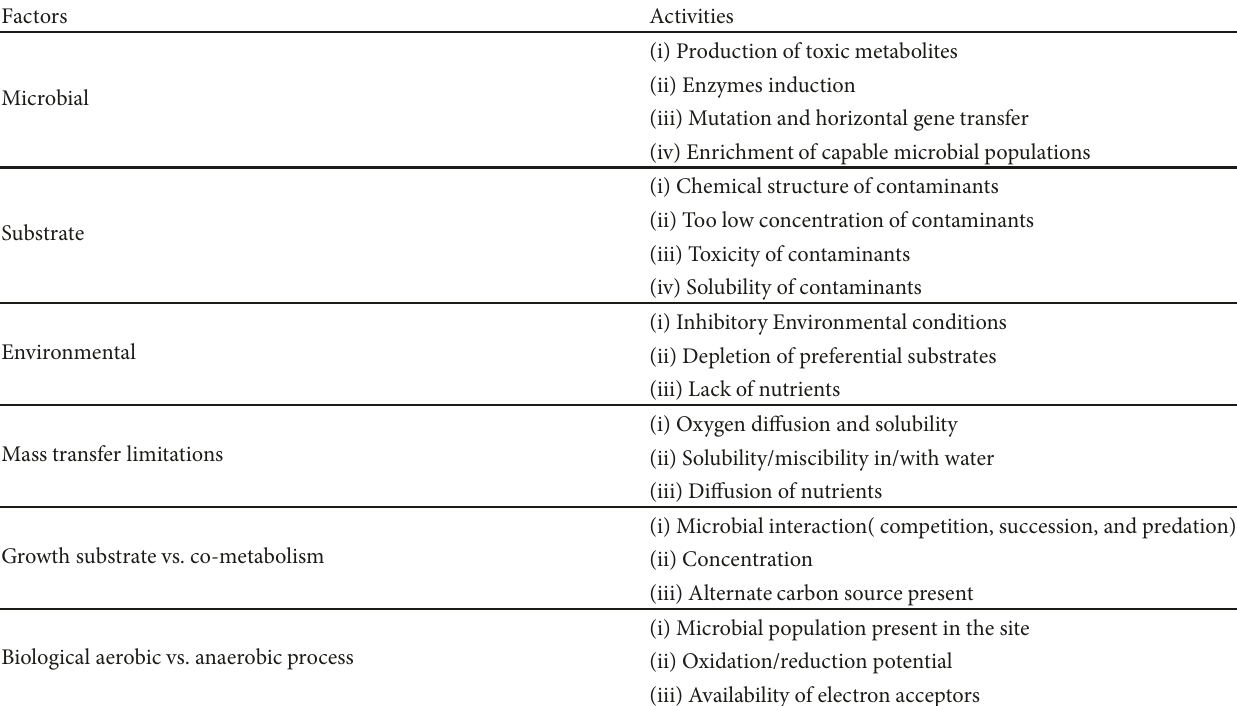
Table 2: Factors that influence bioremediation of heavy metals